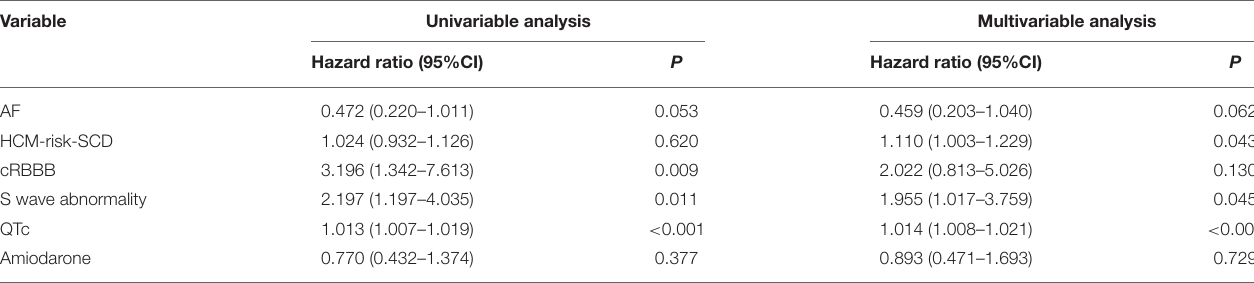
TABLE 2 | Univariable and multivariable models for predictors of appropriate ICD